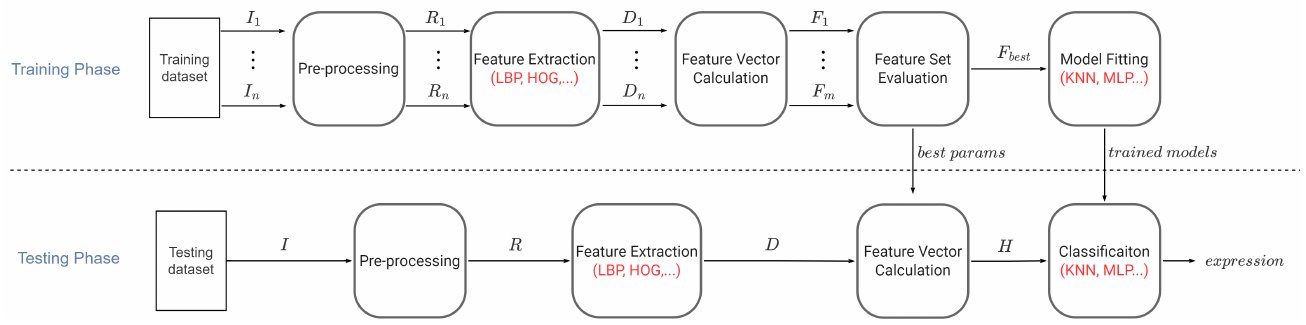
Figure 2. The proposed facial expression recognition